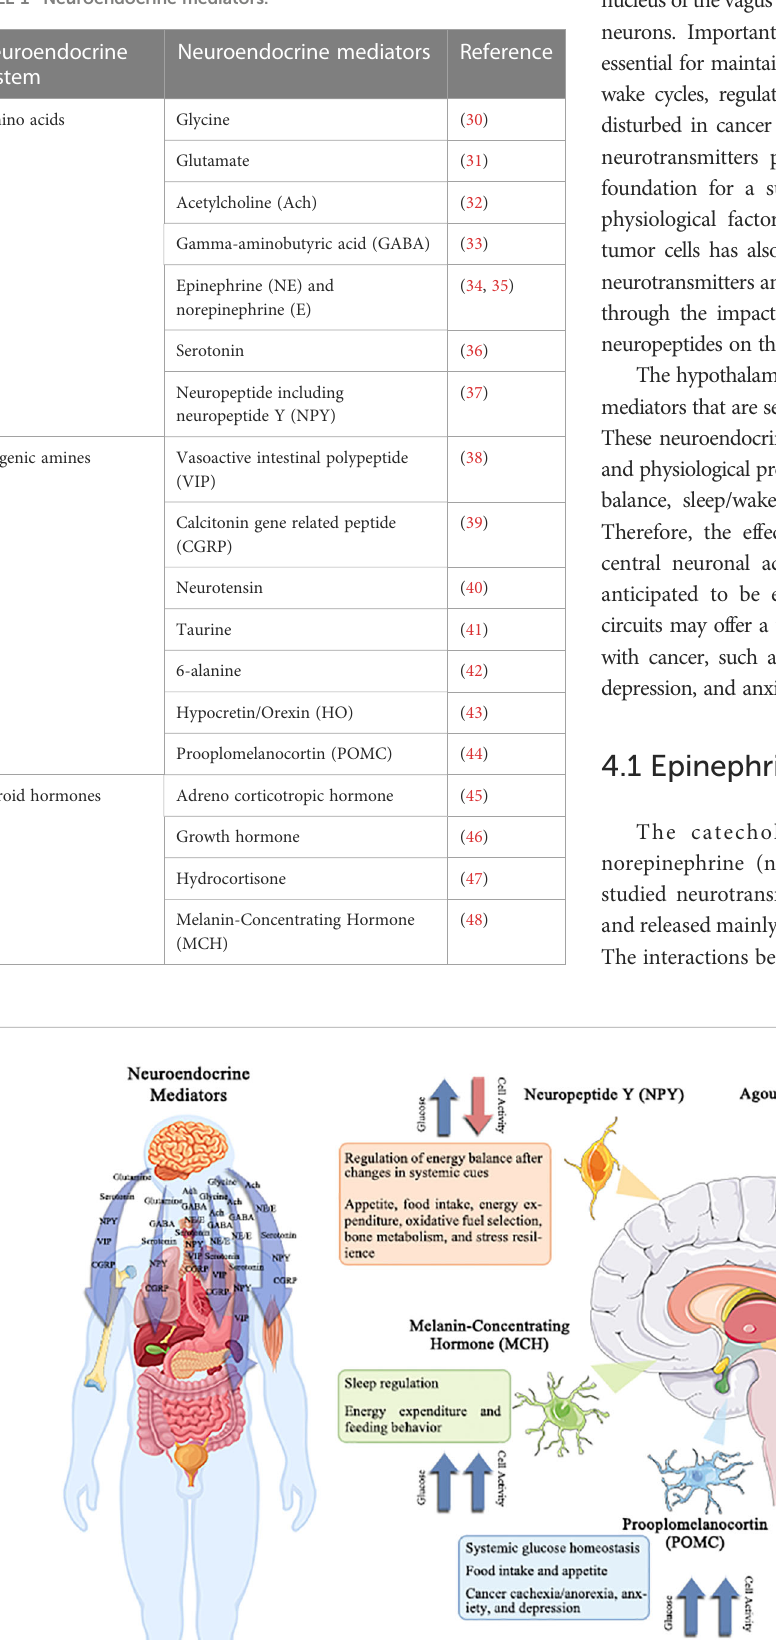
TABLE 1 Neuroendocrine mediators.